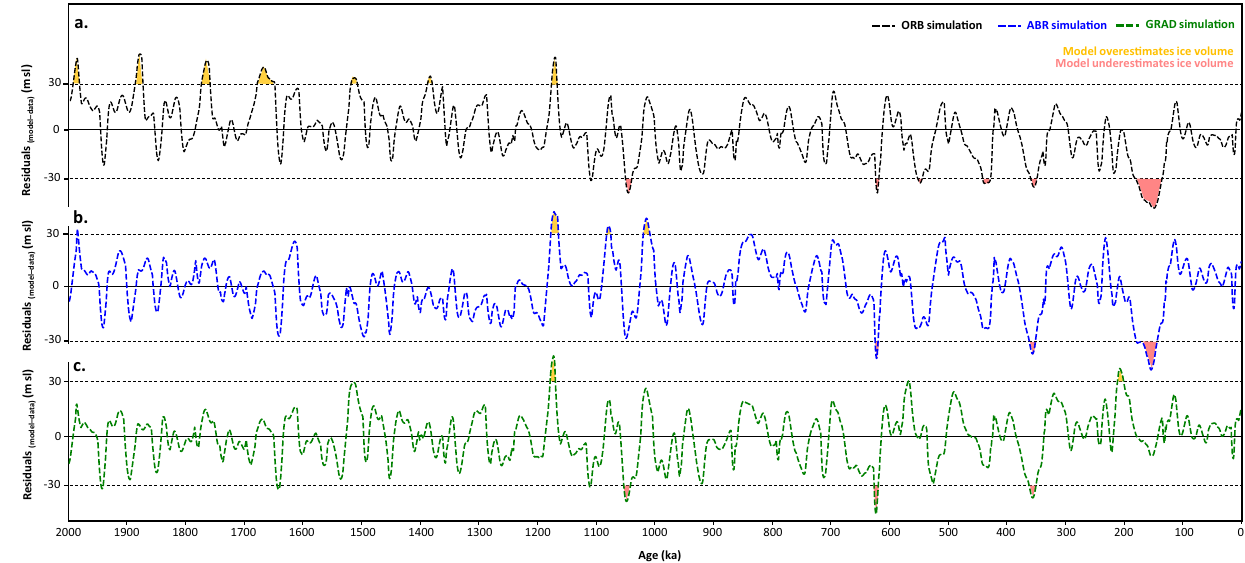
Fig. 2 Residuals between the modelled global ice volume and the reconstructed global ice volume changes. The reconstructed global ice volume is from ref. 41 . ORB ( a ), ABR ( b ) and GRAD ( c ) simulations. Yellow and red areas are time intervals where the model-data deviation exceeds 30